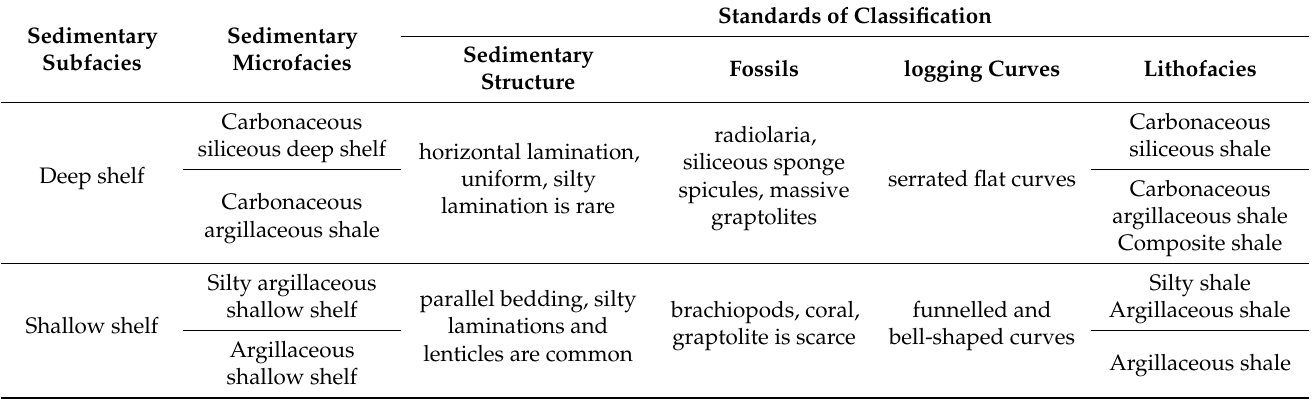
Table 4. Classification standards of sedimentary